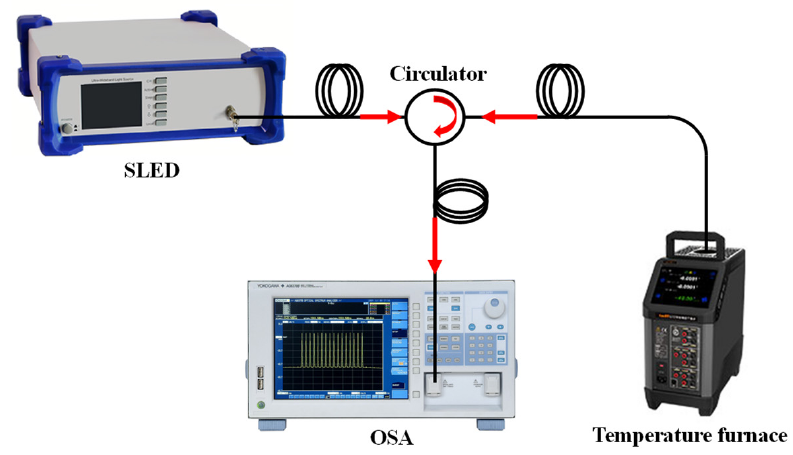
Figure 8. Schematic diagram of the fiber-optic temperature test system.